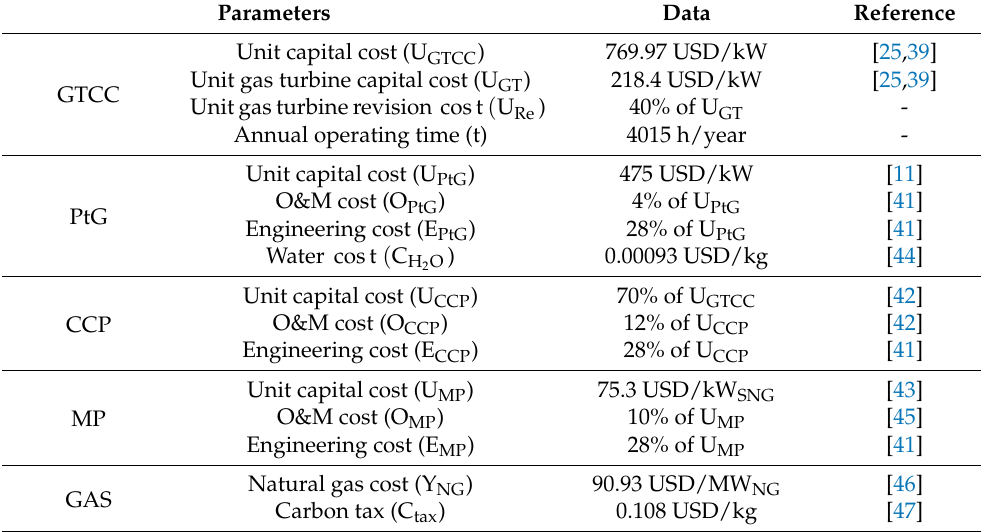
Table 7. Parameters for economic